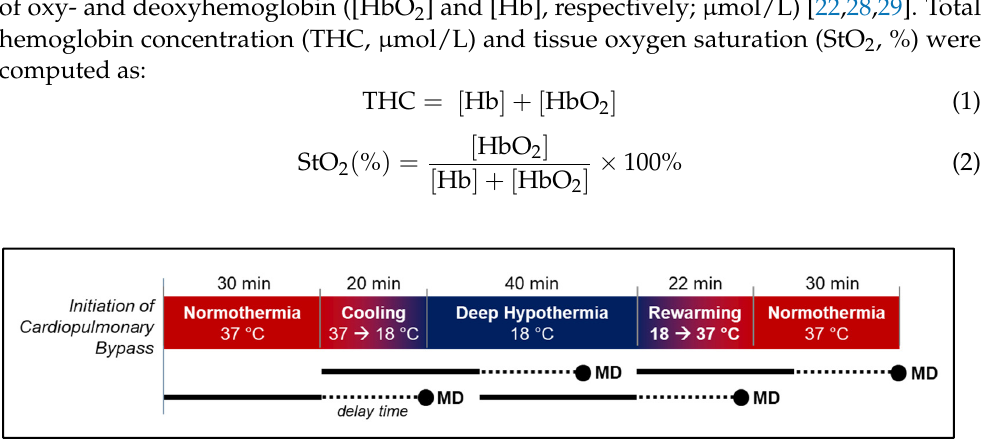
Figure 1. Experimental Protocol and Cerebral Microdialysis (MD) Sampling Timepoints. Following the initiation of cardiopulmonary bypass (CPB) support, animals were maintained at normothermia (nasopharyngeal temperature, NPT, 37 °C) for 30 min. The animals were then cooled to deep hypo- thermia (NPT 18 °C) and received one of three different perfusion strategies for 40 min: deep hypo- thermic CPB (DHCPB), deep hypothermic circulatory arrest (DHCA), or selective antegrade cere- bral perfusion (SACP). All animals were then returned to CPB support and rewarmed to normo- thermia. Four MD sampling timepoints corresponding to normothermic bypass, cooling, deep hy- pothermia, and rewarming are indicated by circles. For each sample, the corresponding 30 min cer- ebral sampling window is indicated by a solid black line. The dotted lines indicate the 20 min delay time used to account for metabolic reaction time, metabolite “washout” time, and transit time of dialysate from the brain to the MD collection vial (note, the solid and dotted lines for MD samples 2 and 4 are above those for MD samples 1 and 3).